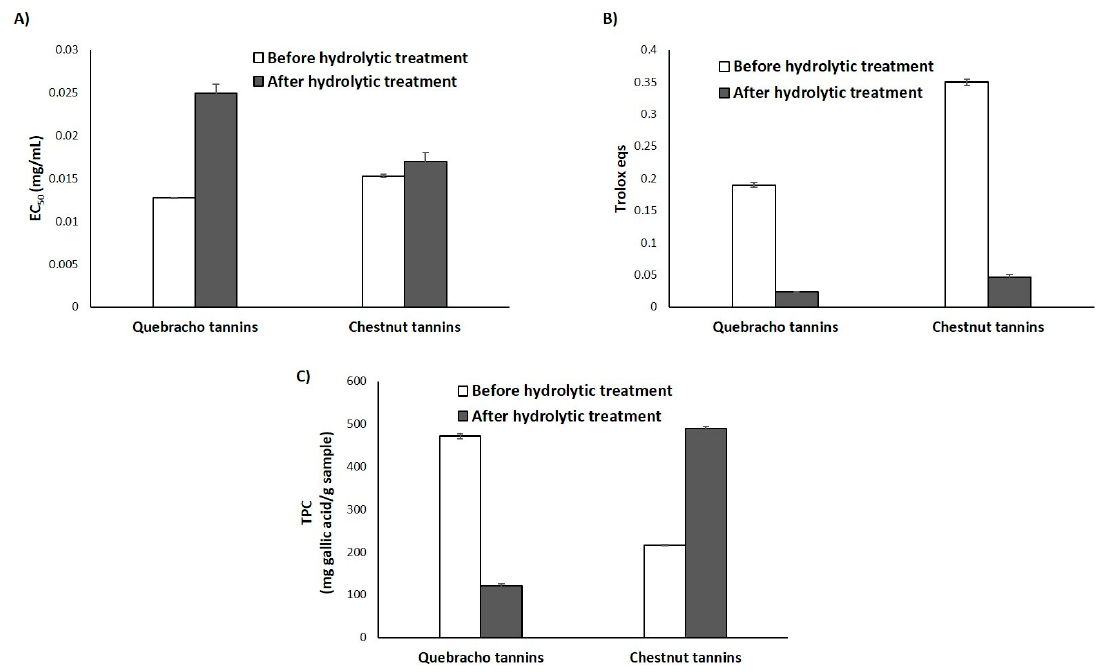
Figure 4. Antioxidant properties and TPC of quebracho and chestnut tannins before and after hydrolytic treatment. ( A ) DPPH assay; ( B ) FRAP assay; ( C ) Folin-Ciocalteu assay. Reported are the mean ± SD values of at least three experiments.